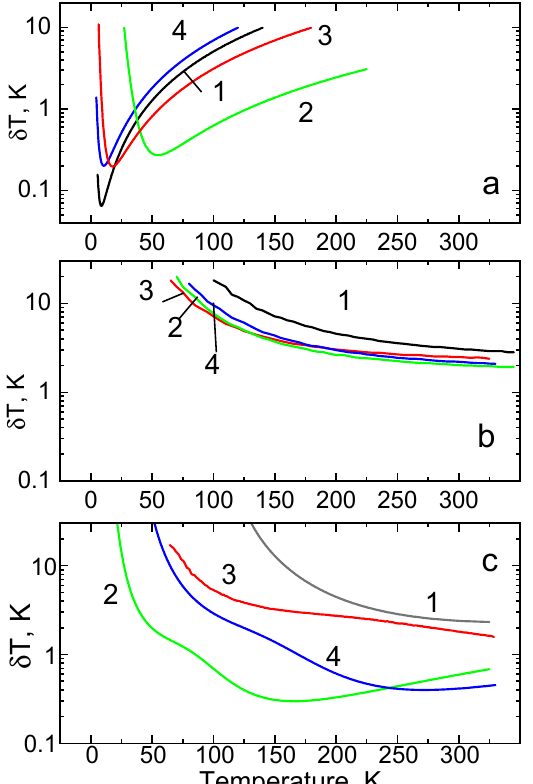
Figure 9. The temperature resolution of Al 2 O 3 -Cr (1, black), Ga 2 O 3 -Cr (2, green), YAlO 3 -Cr (3, red), and Y 3 Al 5 O 12 (4, blue) for different modes of temperature sensing: a ) - luminescence intensity ratio, b ) - wavelength shift, c ) - decay time constant, where the curves are calculated using the fitted 𝜏 = 𝑓(𝑇) dependence and measurement uncertainties.